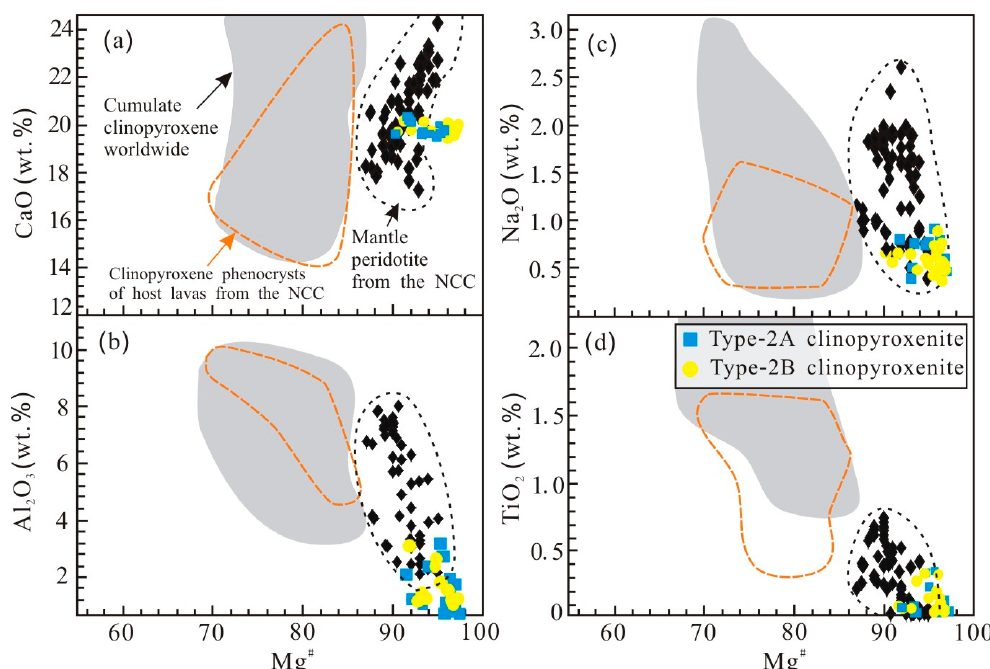
Figure 4. Major element oxides variation diagrams of clinopyroxene in Hujialin type-2 clinopyroxenite ( a ) CaO; ( b ) Na 2 O; ( c ) Al 2 O 3 ; ( d ) TiO 2 . Data sources: cumulate clinopyroxene worldwide is based on Liu and Ying [35] and references therein; field of clinopyroxene phenocrysts of host lavas from the North China Craton (NCC) is from Xu et al. [36], and Liu and Ying [35]; mantle peridotite from the NCC is from the Zheng et al. [37,38], Ying et al. [39], and Xu et al. [36,40].